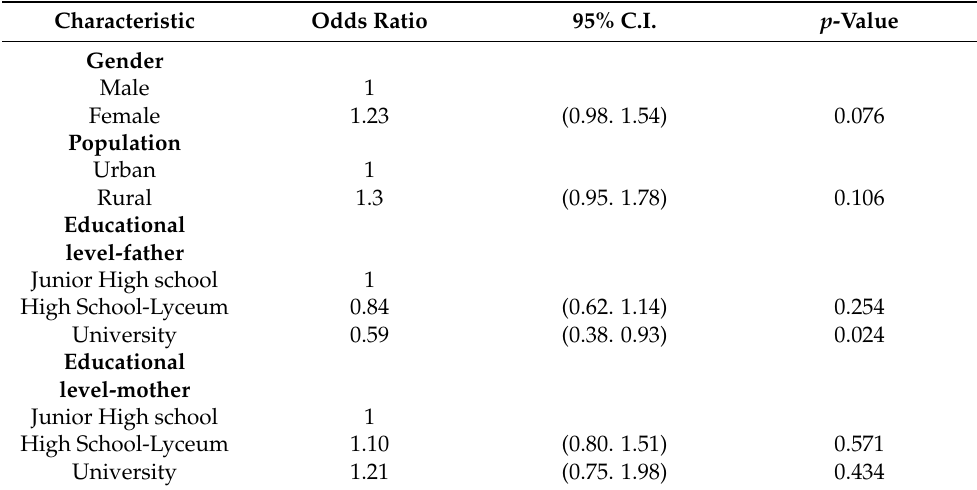
Table 9. Association between need for orthodontic treatment and childrens’ demographic character- istics (12-y.o.). Results from a multivariable logistic regression model. Characteristic Odds Ratio 95% C.I. p -Value